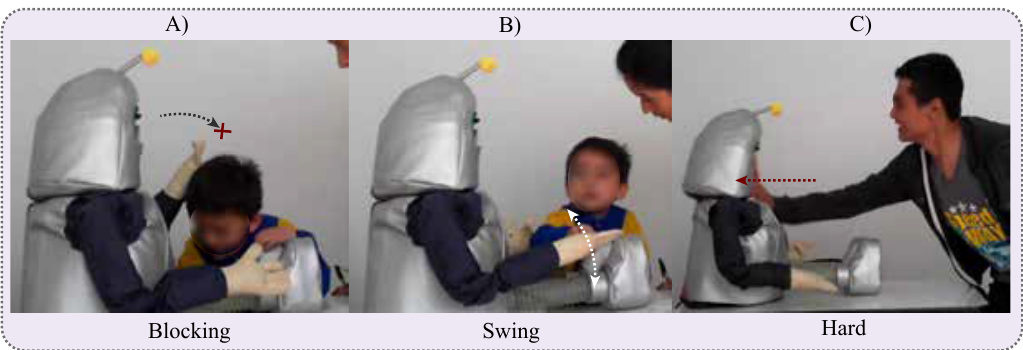
Figure 14. Physical interactions exhibited by the participants during the session: ( A ) blocking, ( B ) swing, and ( C ) hard.